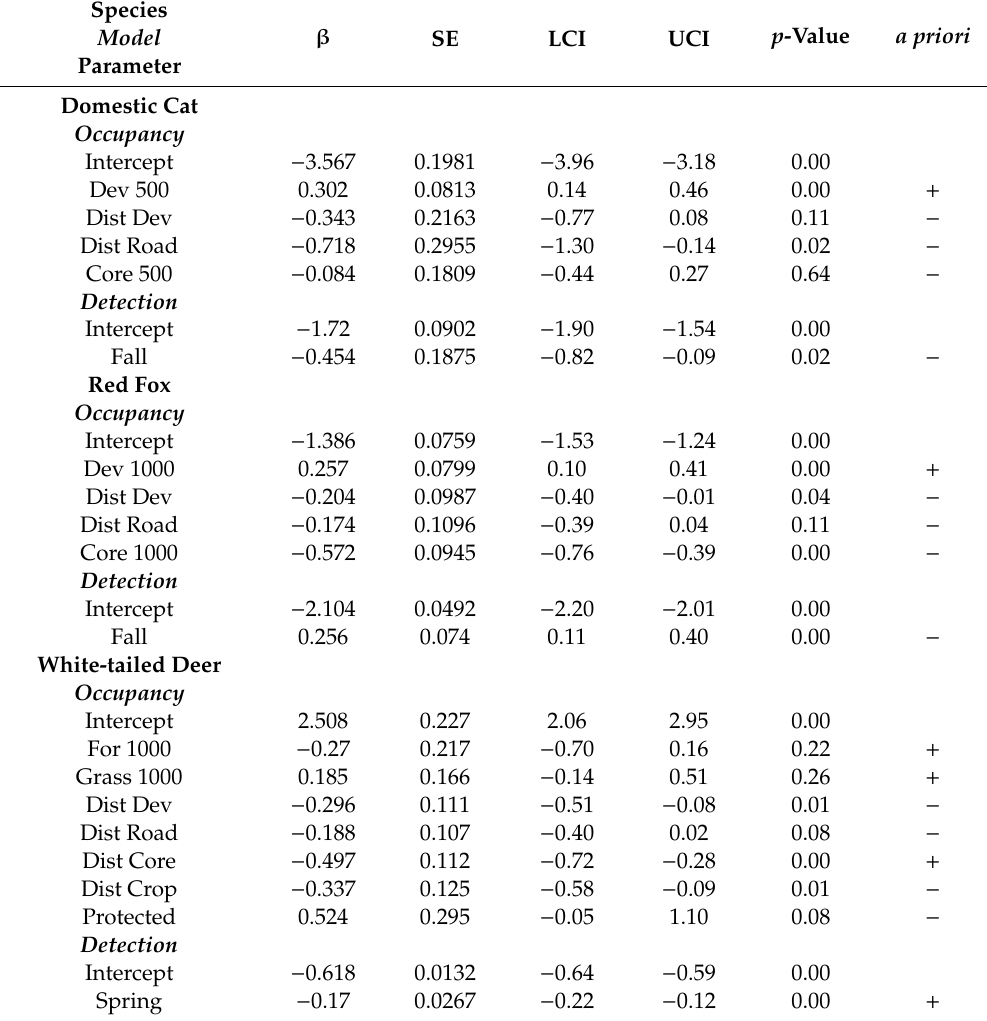
Table 2. Estimated beta coe ffi cients ( β ) with standard errors (SE), 95% lower and upper confidence intervals (LCI, UCI), p -values, and a priori predictions for covariate e ff ects from the top-ranking occupancy model, explaining variation in occupancy and detection e ff ects of land cover and anthropogenic covariates on the probability of site use by synanthropic mammals from 1591 camera trap locations across an urban to rural gradient, northern Virginia, 2012–2018. Species β